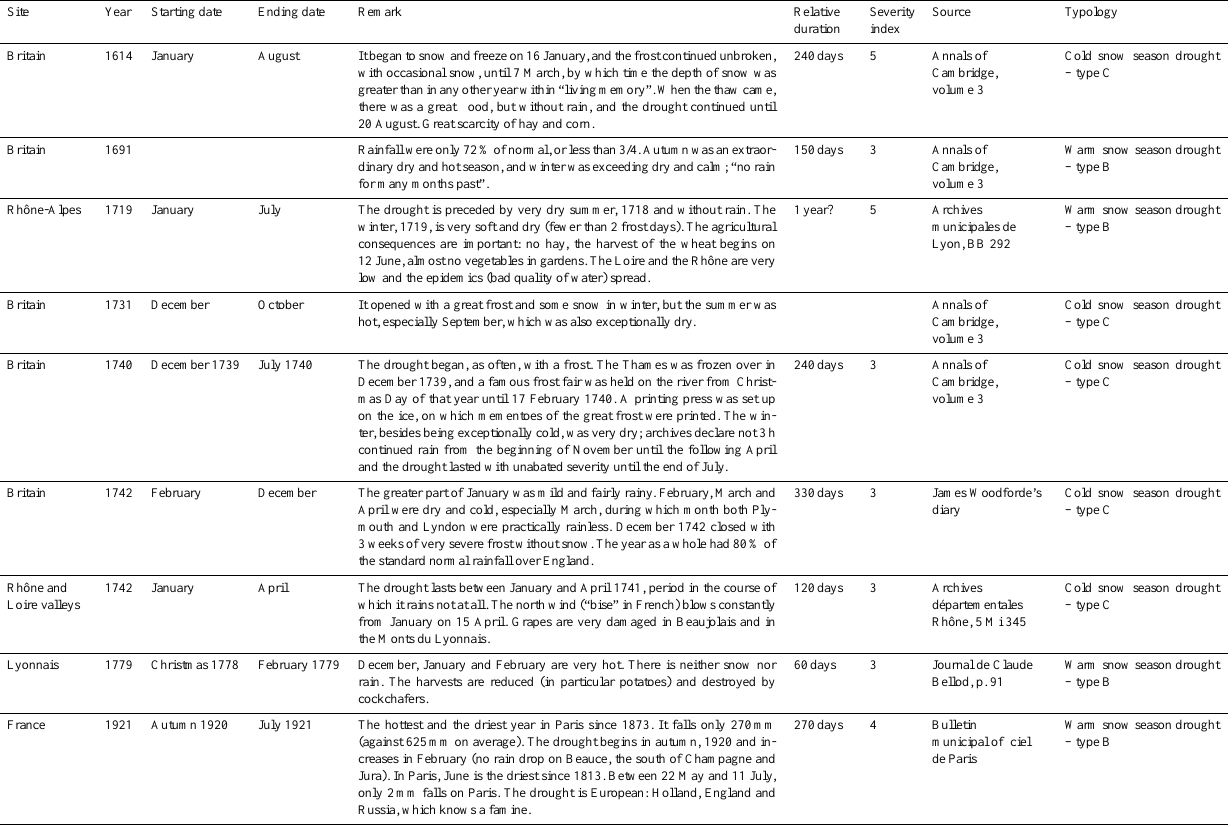
Table 5. Selected drought events in England and France that are connected to anomalies in winter temperature, snow, and/or frost.